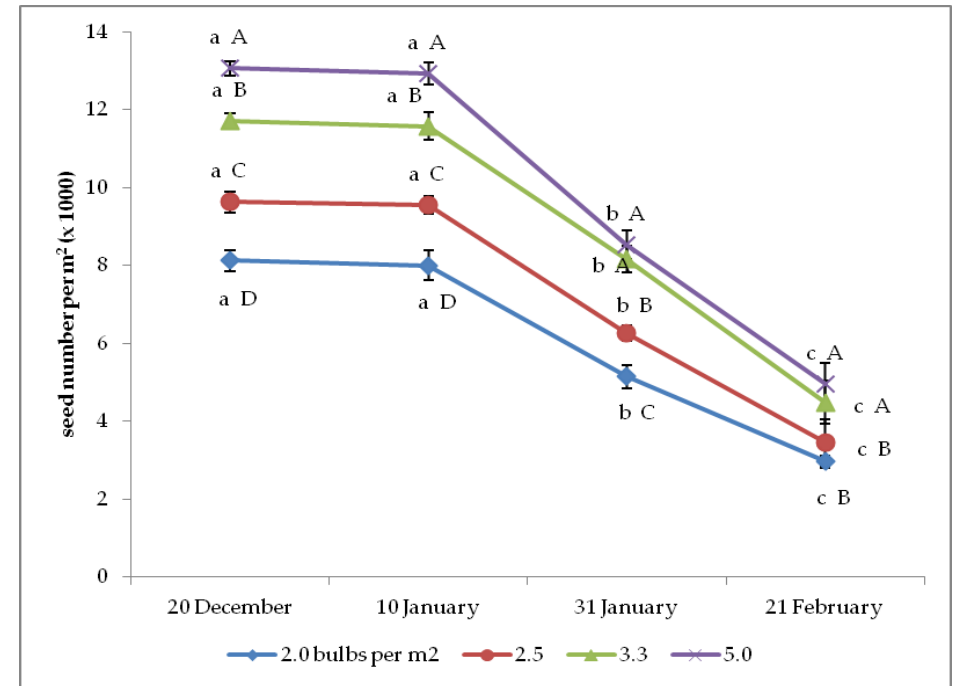
Figure 4. Interaction between bulb planting time and density on onion seed number per m 2 ( n = 3). Different letters mean significant difference in the comparison between planting times (lowercase letters) or between bulb densities (capital letters), according to the Duncan test at p ≤ 0.05. Standard deviation bars are shown per each value. Plants 2019 , 8 , x FOR PEER REVIEW